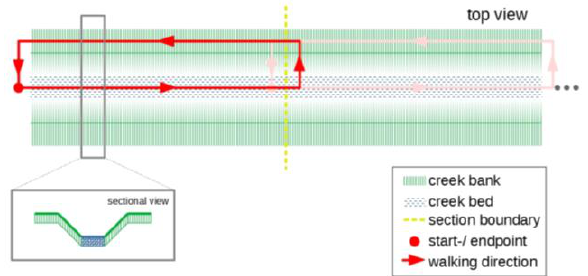
Figure 1 . Principle of the measurement